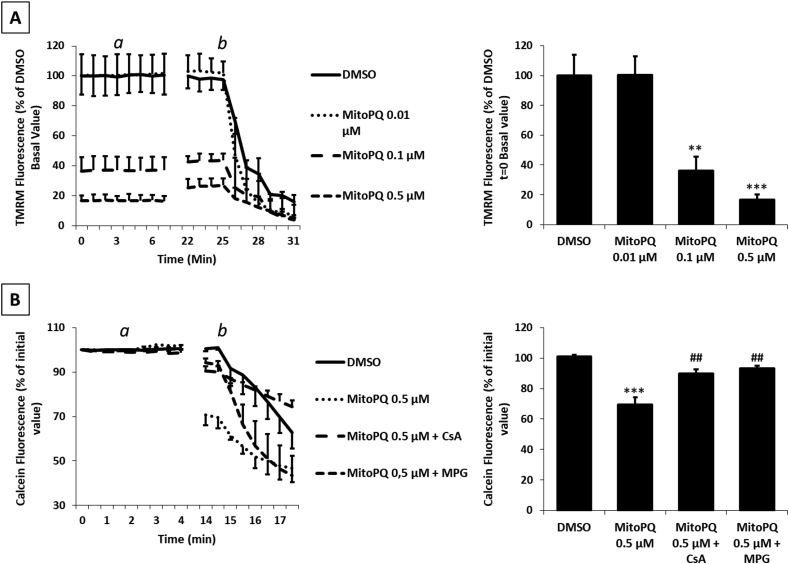
Effects of MitoPQ on mitochondrial membrane potential and mPTP opening. A) Mitochondrial membrane potential (ΔΨm) monitored by TMRM fluorescence in isolated NRVMs following incubation for 2 h with MitoPQ at different concentrations a: 4 μM oligomycin, b: 4 μM FCCP. B) mPTP opening monitored by decrease of calcein fluorescence in isolated NRVMs pretreated for 30 min with or without 1 μM CsA or 500 μM MPG. a: treatment with DMSO as control or 0.5 μM MitoPQ; b: 5 μM Calcimycin. Data were quantified 12 min after treatment with MitoPQ/DMSO. Approximately 30 cells were analysed per condition in each experiment and all the experiments were performed at least three times. Data are expressed as mean ± SEM. *p < 0.05, **p < 0.01, ***p < 0.001 vs DMSO vehicle; #p < 0.05, ##p < 0.01, ###p < 0.001 vs MitoPQ.